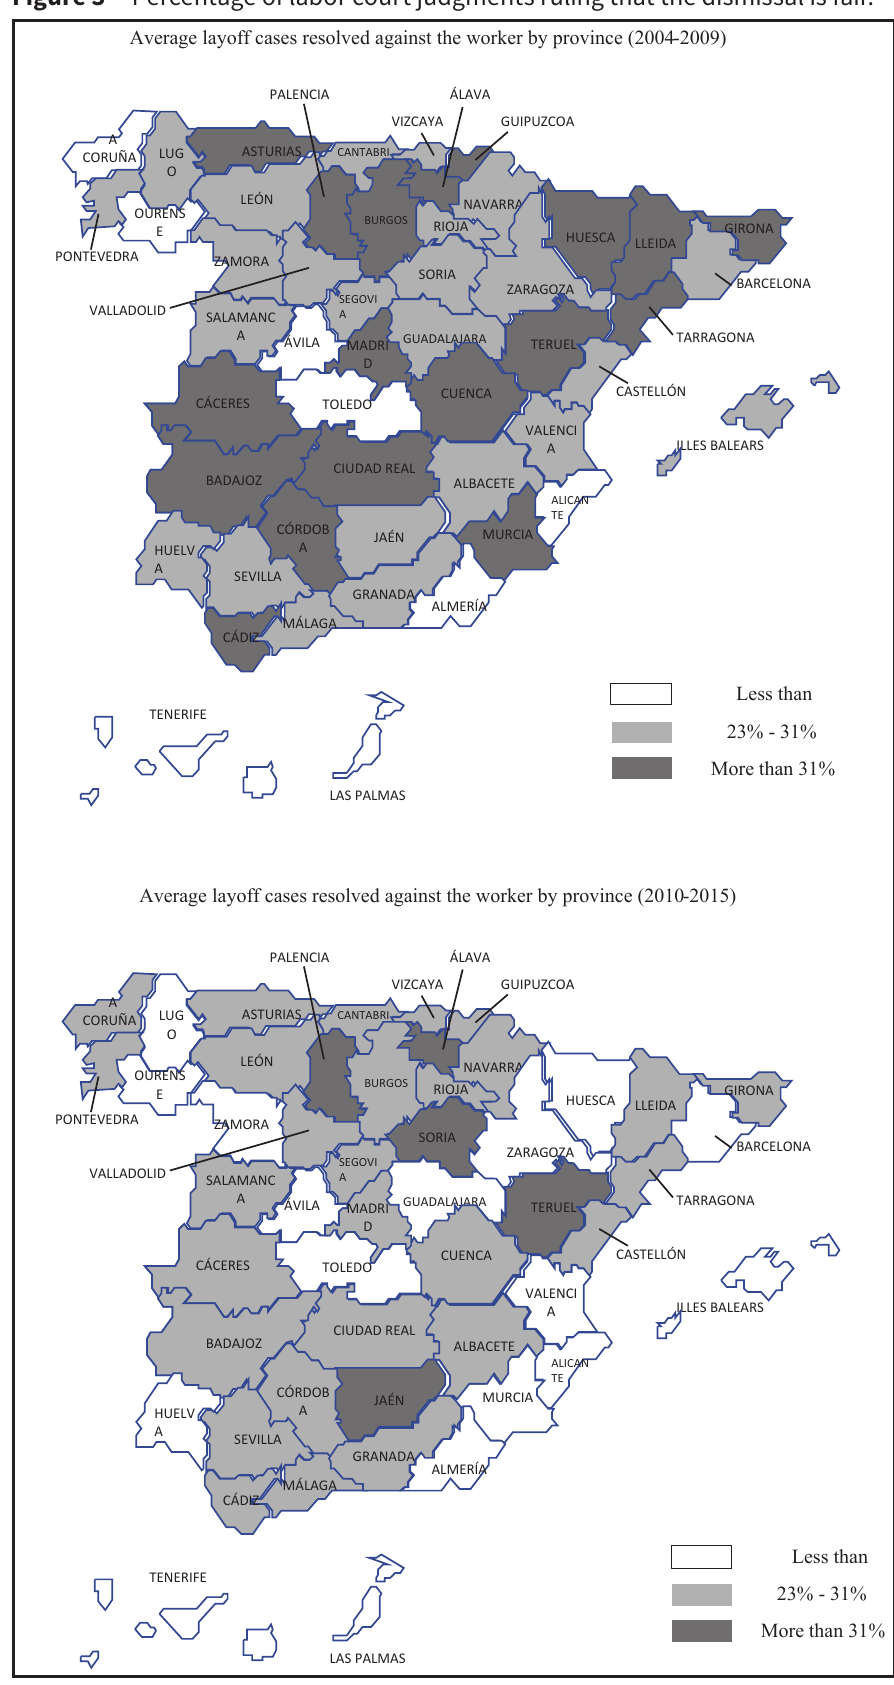
Figure 3 Percentage of labor court judgments ruling that the dismissal is